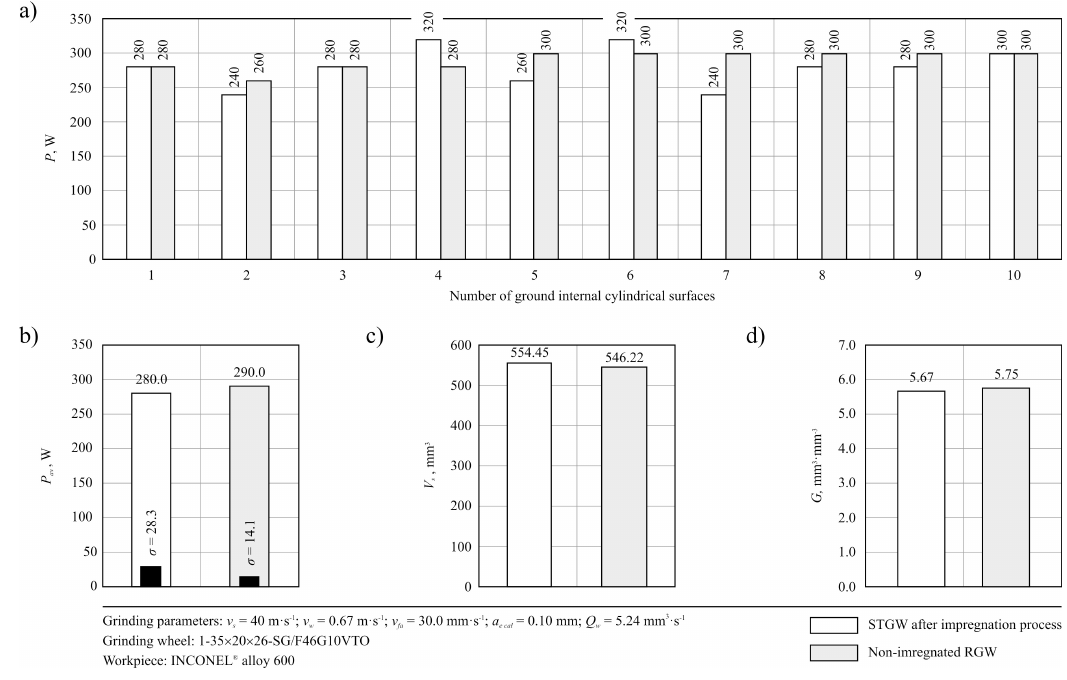
Figure 7. Collection of exemplary results, including values of grinding power and values of parameters describing the durability period of the grinding wheels studied: ( a ) changes in grinding power P during machining of internal surfaces of 10 rings; ( b ) average value of the grinding power P avr and its standard deviation σ ; ( c ) volumetric wear of the grinding wheel V s ; ( d ) grinding ratio G = V w / V s .